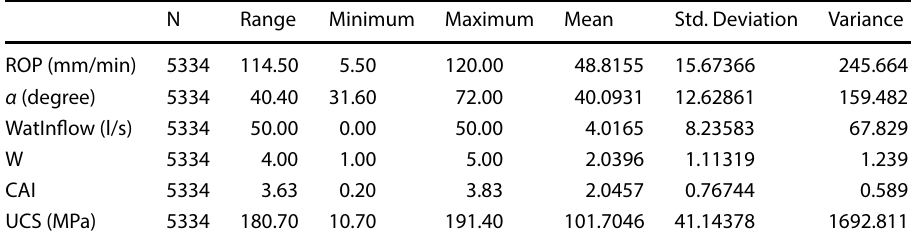
Table 2 Statistical summaries of the input and output parameters